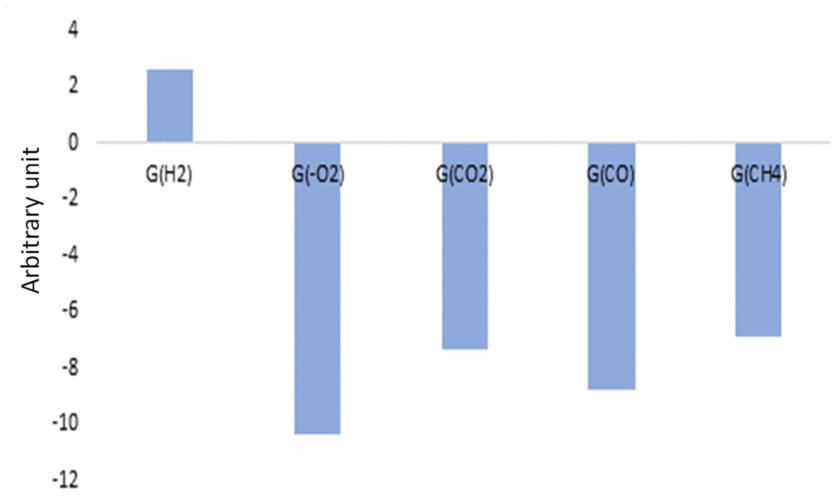
Figure 19. CCs loading depending on the polymer model type.